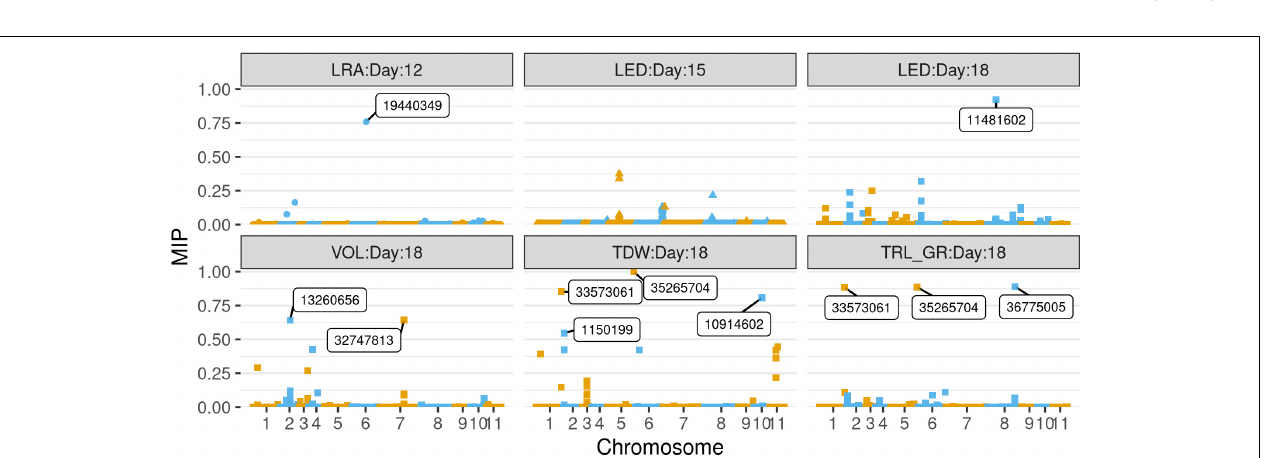
FIGURE 9 | Selection of variables with embedded screening (SVEN) plots of marginal inclusion probability (MIP) vs chromosomes of SNP markers associated with the mung bean traits LRA (day 12), LED (day 15), and LED, VOL, TDW, TRL_GR for day 18. Significant SNPs are boxed with the marker